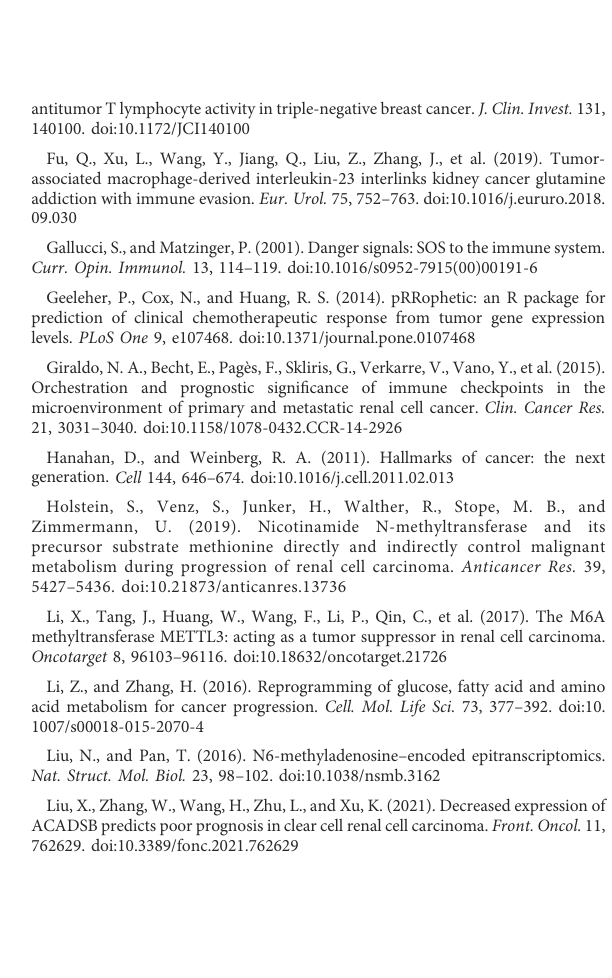
SUPPLEMENTARY FIGURE S1 Landscape of gene mutation in ccRCC. SUPPLEMENTARY FIGURE S2 Tumour mutational burden and microsatellite instability analysis; TMB: tumour mutational burden; MSI: microsatellite instability. SUPPLEMENTARY FIGURE S3